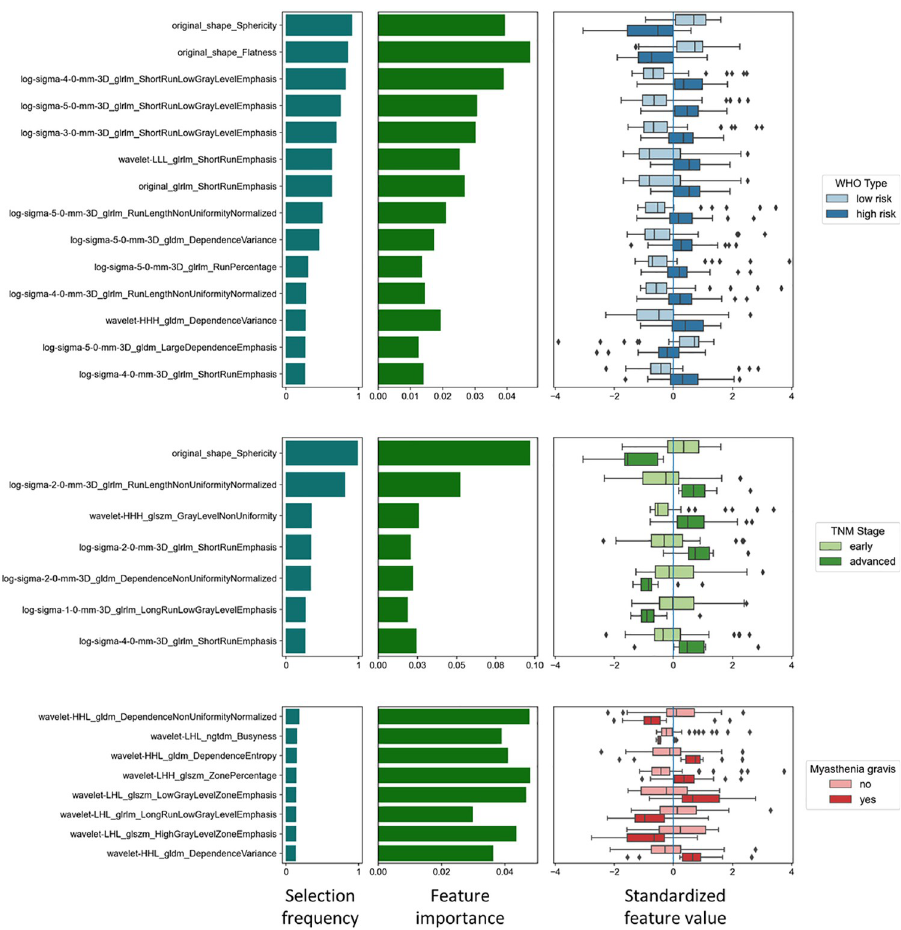
Fig 2. Feature selection. Features selected for the prediction of a) histologic subtype (WHO classification, low-risk vs. high-risk tumors), b) TNM stage (IASLC/ITMIG, early vs. advanced stage) and the presence of c) myasthenia gravis. The bar plots on the left display how often features were selected across folds as an indicator of selection stability. The bar plots in the center show the feature importance measured by the mean absolute SHAP values, representing the impact of a feature on the individual model prediction. The boxplots on the right display the individual standardized feature values grouped by the underlying category. The selected feature values differed significantly for all tested categories (p <